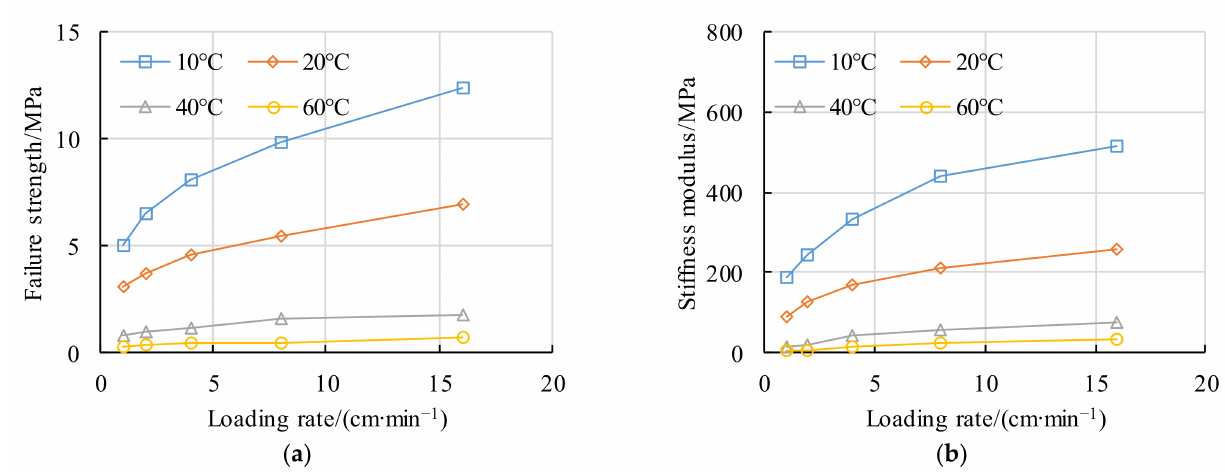
Figure 5. Effect of loading rate and temperature on compression results of 20% CRA mixture: ( a ) failure strength; ( b ) stiffness modulus.